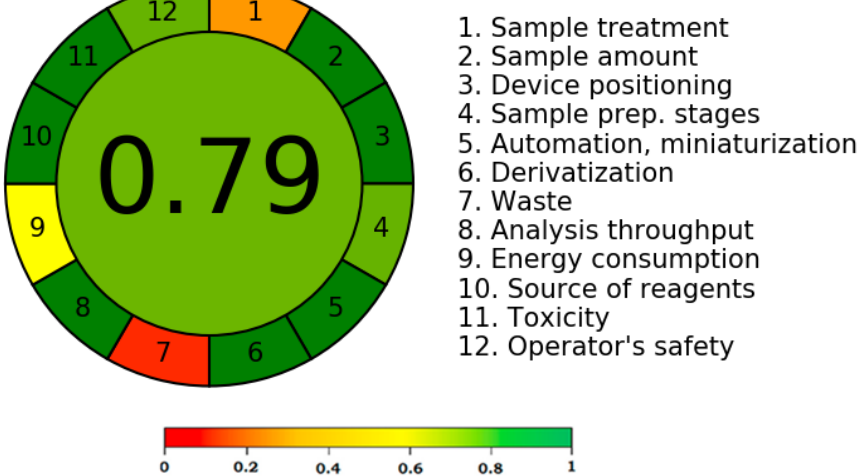
Figure 6. The representative pictogram for AGREE scale for the current protocol derived using AGREE calculator.